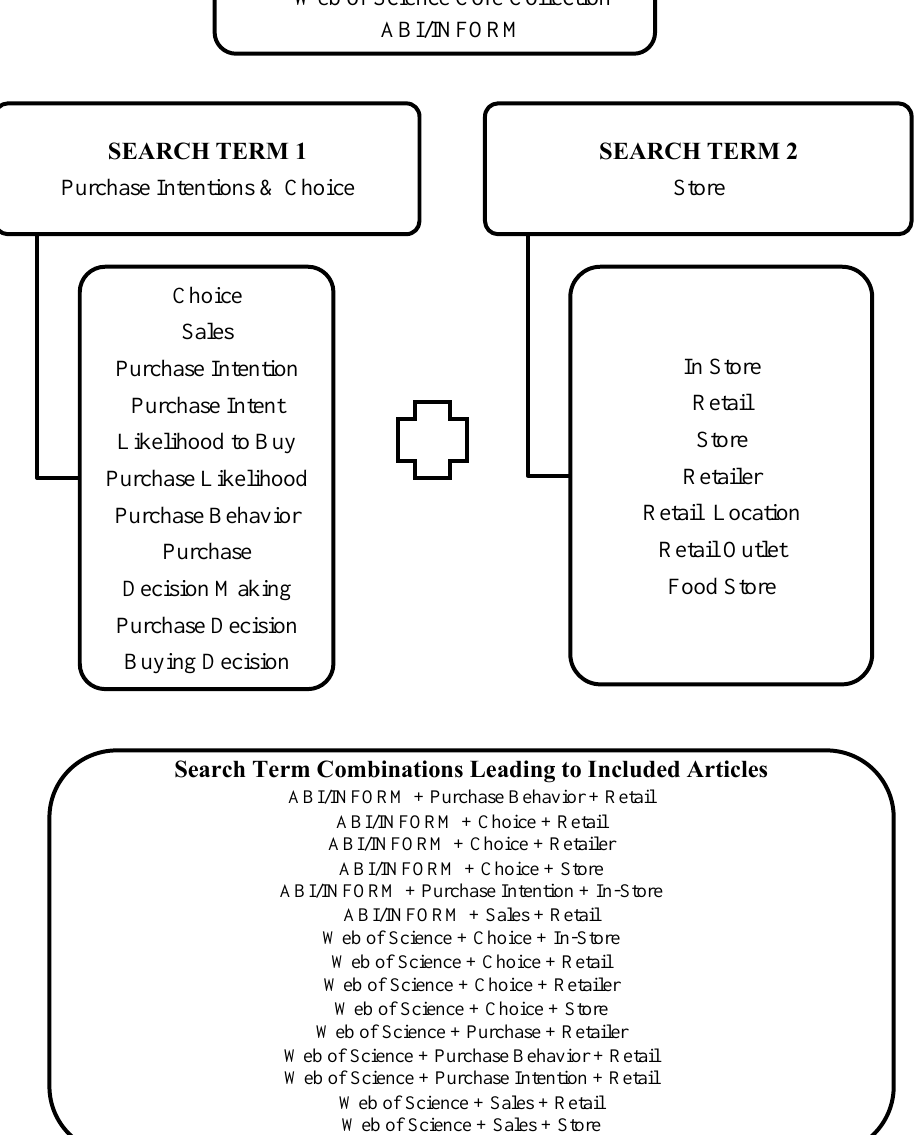
Figure 1. Databases, search terms, and search combinations leading to included articles.